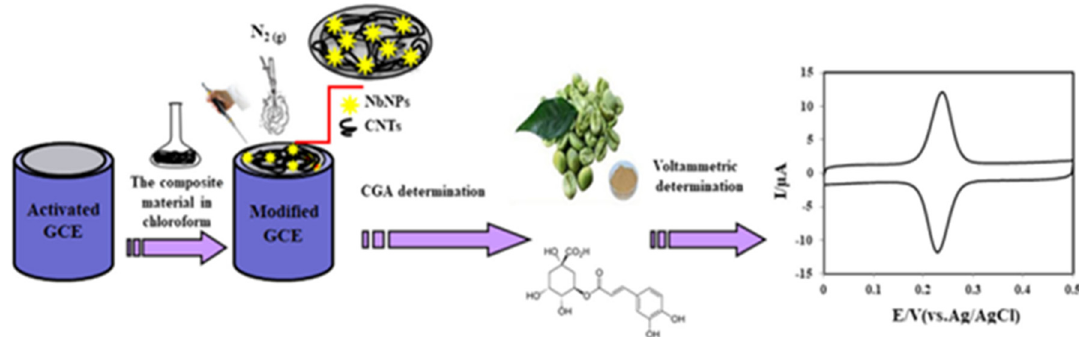
Figure 9. A simple illustration for the preparation of the platform and its application in electroanalysis. Published from [67] with the permission of the publisher.